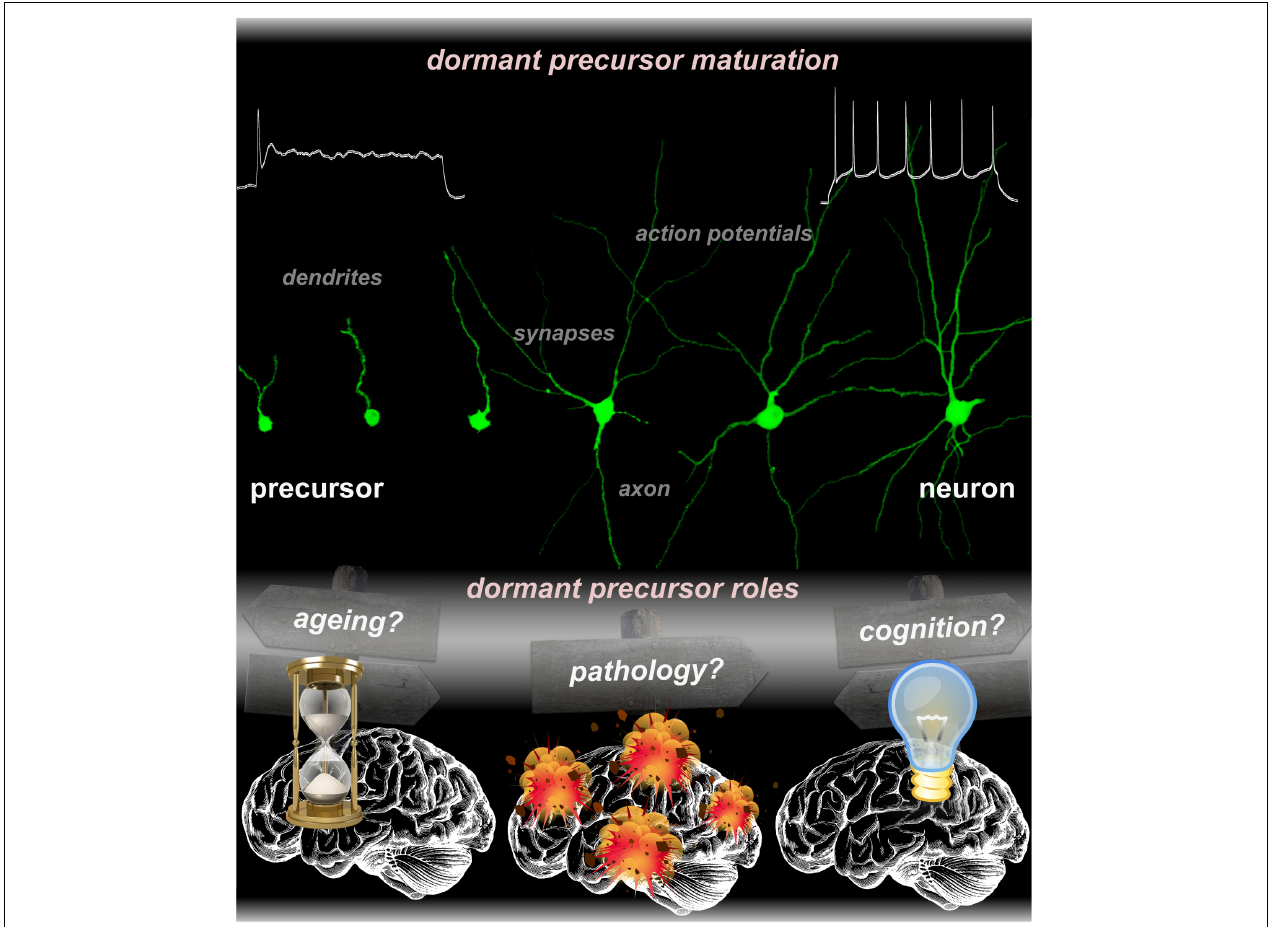
FIGURE 1 | Micrographs collection representing various states of dormant precursors undergoing progressive maturation, from an inactive to a fully functional neuron. The function(s) of dormant precursors is still elusive. Current research across multiple species suggested potential roles in aging, pathology, and